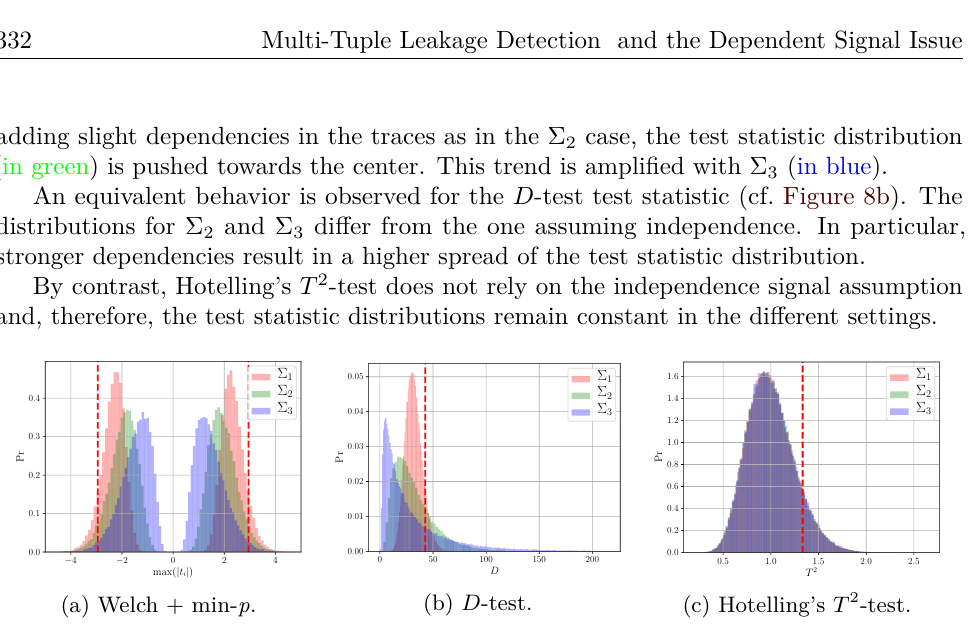
Figure 8: Null distributions with dependent noise and detection thresholds (dashed lines).